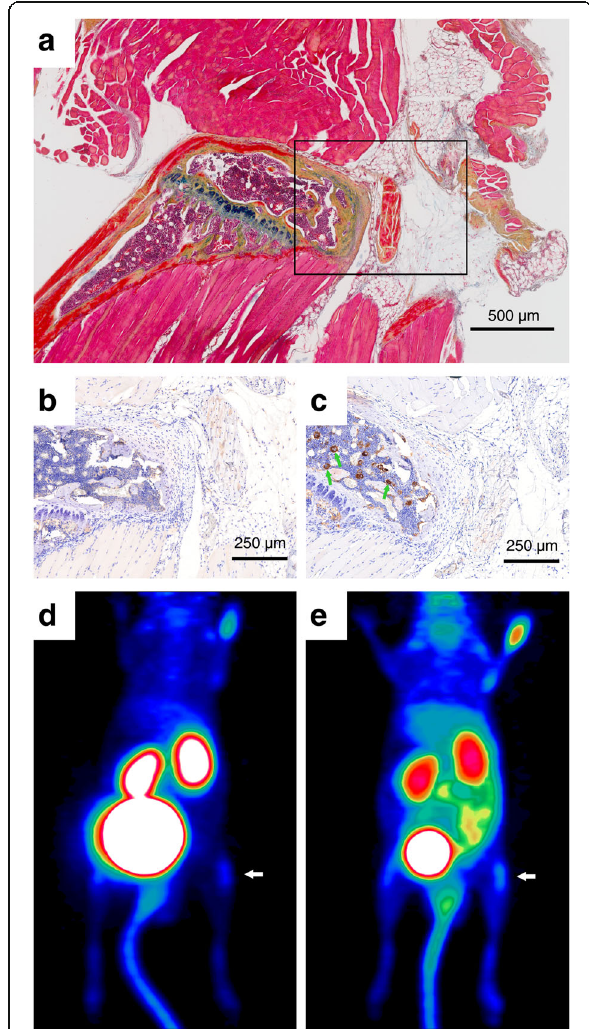
Fig. 3 Integrin expression in non-arthritic joints. a MOVAT pentachrome staining of the right knee of a CIA mouse from week 2. The immunohistochemistry staining of consecutive slices for integrin α 5 ( b ) and β 3 ( c ), (depicted area corresponds to the inset frame in a ). The same mouse was subjected to PET imaging of α 5 β 1-integrin using 68Ga-Aquibeprin ( d ) and of α v β 3-integrin using 68 Ga-Avebetrin ( e ), wherein the white arrow indicates the knee subjected to staining ( a , b , c ). No significant α 5 expression was found ( b ), confirming the absence of α 5 β 1. Focal expression of β 3 ( c , green arrows) originates from the expression of the platelet integrin α IIb β 3 by megakaryocytes (platelet progenitor cells); no significant β 3 expression elsewhere confirms the absence of α v β 3. Consistently, both tracers show a low uptake in a non-arthritic knee. Color coding of μ PET images ( d , e ) is similar to Fig.